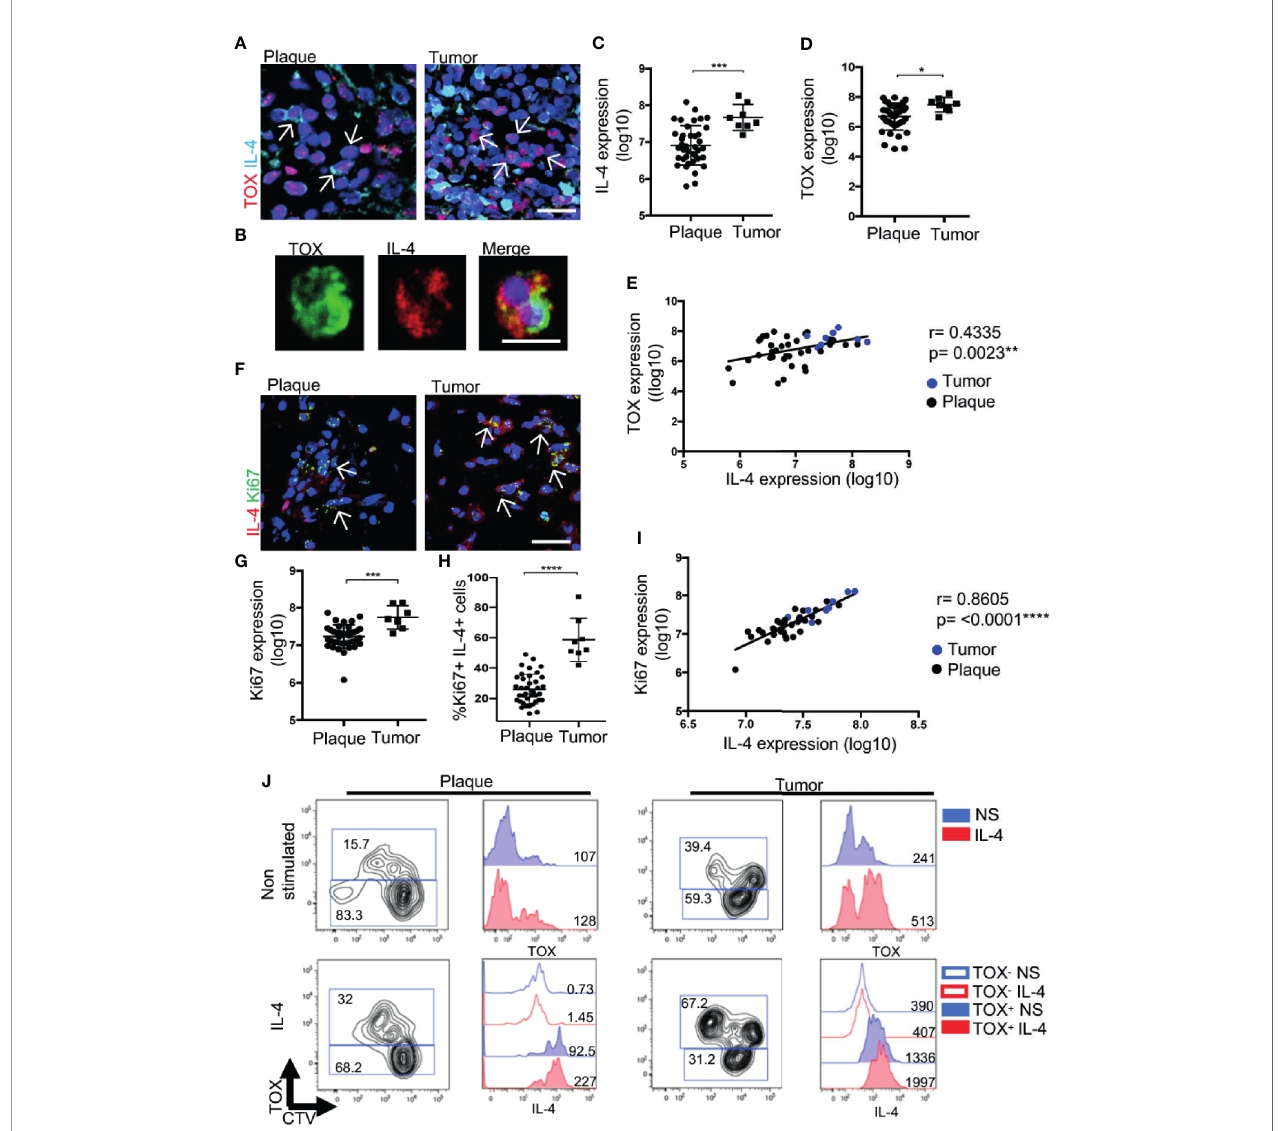
FIGURE 6 | IL-4 increases CTCL features associated with disease progression. (A) Representative immuno fl uorescence (IF) of TOX (AF-594) and IL-4 (AF-647) expression in CTCL plaques and tumors. (B) Representative microphotographs of CD4 + T cells isolated from tumors showing TOX (AF-488) and IL-4 (AF-594) expression (n = 3). Quanti fi cation of the total expression of (C) IL-4 and (D) TOX in the microphotographs of plaques (n = 39) and tumors (n = 8). (E) Correlation between IL-4 and TOX expression quanti fi ed from (A) (black dot: plaque; blue dot: tumor). (F) Representative IF of Ki67 (AF-488) and IL-4 (AF-594) expression in CTCL plaques and tumors. Quanti fi cation of the total expression of (G) Ki67 and (H) percentage of Ki67 + IL-4 + cells in the microphotographs of CTCL plaques (n = 39) and tumors (n = 8). (I) Correlation between IL-4 expression and Ki67 expression quanti fi ed from (F) (black dot: plaque; blue dot: tumor). (J) Flow cytometric analysis of CTCL plaques and tumor cells treated with IL-4. Left images show the proliferating CellTrace Violet mark (CTV) and percentage of TOX + cells. Right images are representative histograms of nonstimulated cells (blue, NS) or IL-4-treated cells (red, IL-4) showing the expression of TOX and IL-4 from gated CD4 + TOX + and CD4 + TOX - cells. Numbers represent MFI. Arrows of IF images indicate coexpression of markers in the different staining. Error bars = SEM. *P < 0.05; ***P < 0.001; ****P < 0.0001. Scale bars= 20